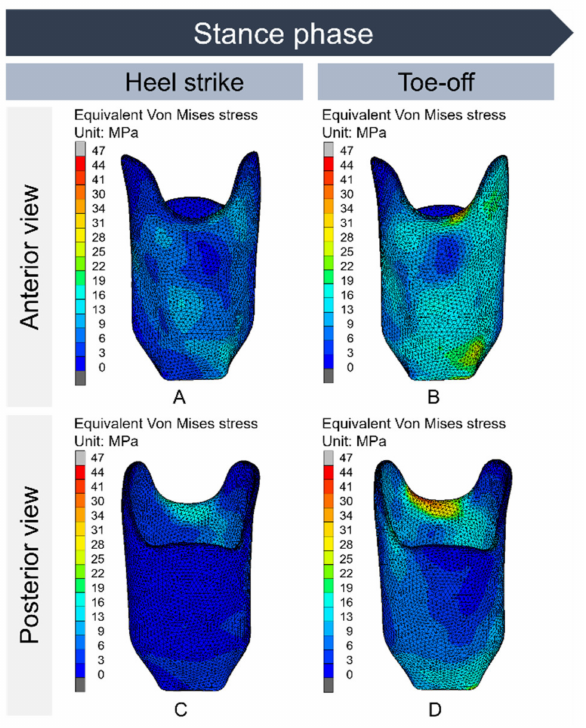
Figure 3. Von Mises stresses were present in an FFF-printed socket with a wall thickness of 4 mm when subjected to the load cases as defined in ISO 10328. ( A ) Front view in heel strike phase. ( B ) Front view in toe-off phase, ( C ) Rear view in heel strike phase, ( D ) Rear view in toe-off phase. In both load cases, the highest stress in the socket wall occurred at the patella tendon area, while the stress values at the height of the tibial tuberosity remained low. Higher stresses were present during toe-off compared with heel strike, probably due to larger moment arms between the applied force and the socket bottom. Von Mises stress values in the patella tendon area reached the ultimate tensile strength of the printed tough PLA during